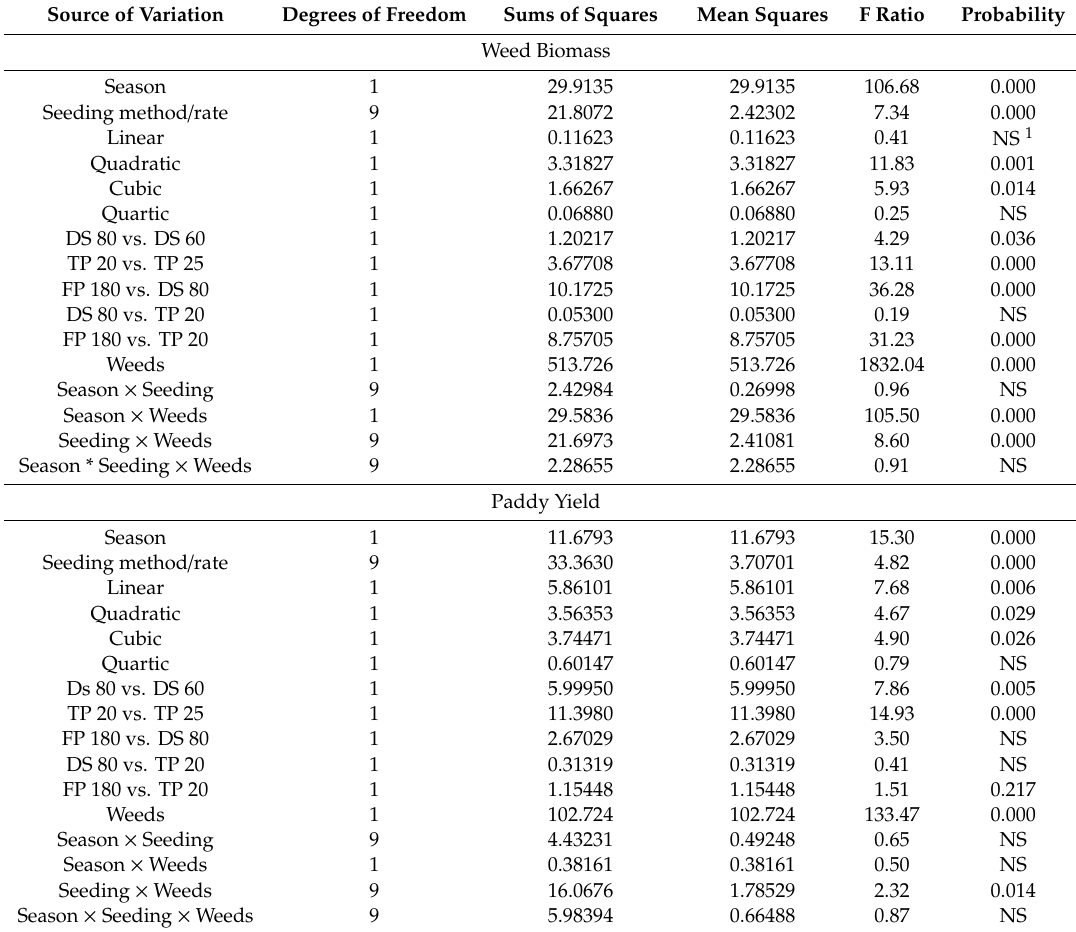
Table 4. Analysis of variance for weed biomass and paddy yield for seeding rate ad seeding method